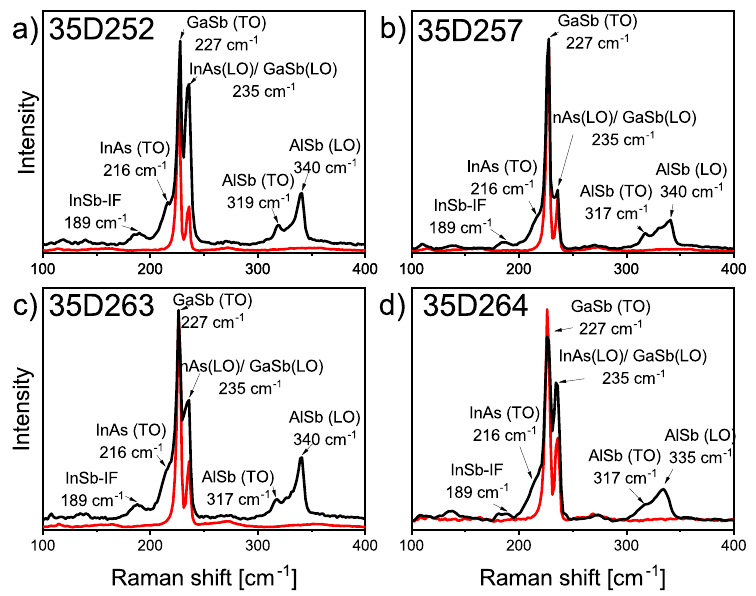
Figure 7. Room temperature Raman scattering spectra of InAs/AlSb T2SL (black curves): ( a ) 35D252, ( b ) 35D257, ( c ) 35D263, ( d ) 35D264 sample against the spectra of GaSb substrate (red